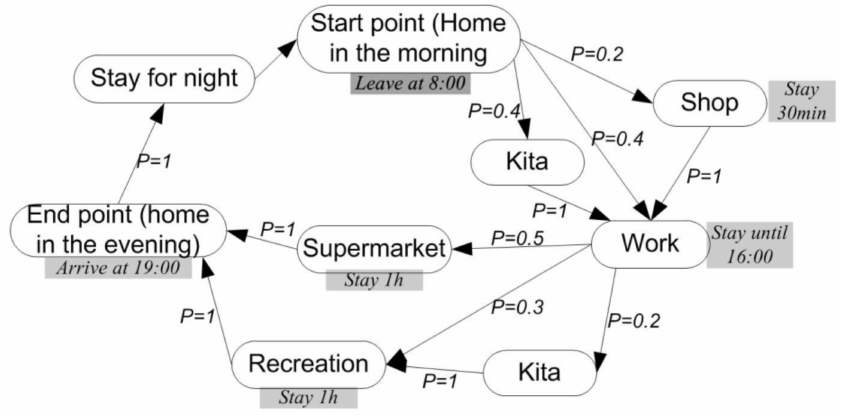
Figure 2. Example of daily routines with priorities p for a female agent who is employed, aged 30–45, and has one